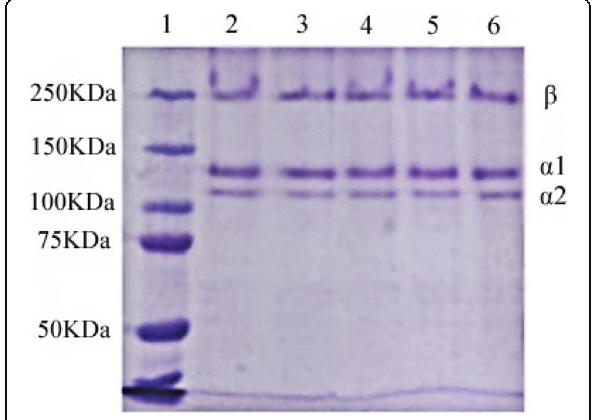
Fig. 4 SDS-PAGE analysis of collagen samples dissolved in different concentrations of [EMIM][Ac]. (1)Markers, (2)Col/ILs-soluble10%, (3)Col/ ILs-soluble30%, (4)Col/ILs-soluble50%, (5)Col/ILs-soluble70%,